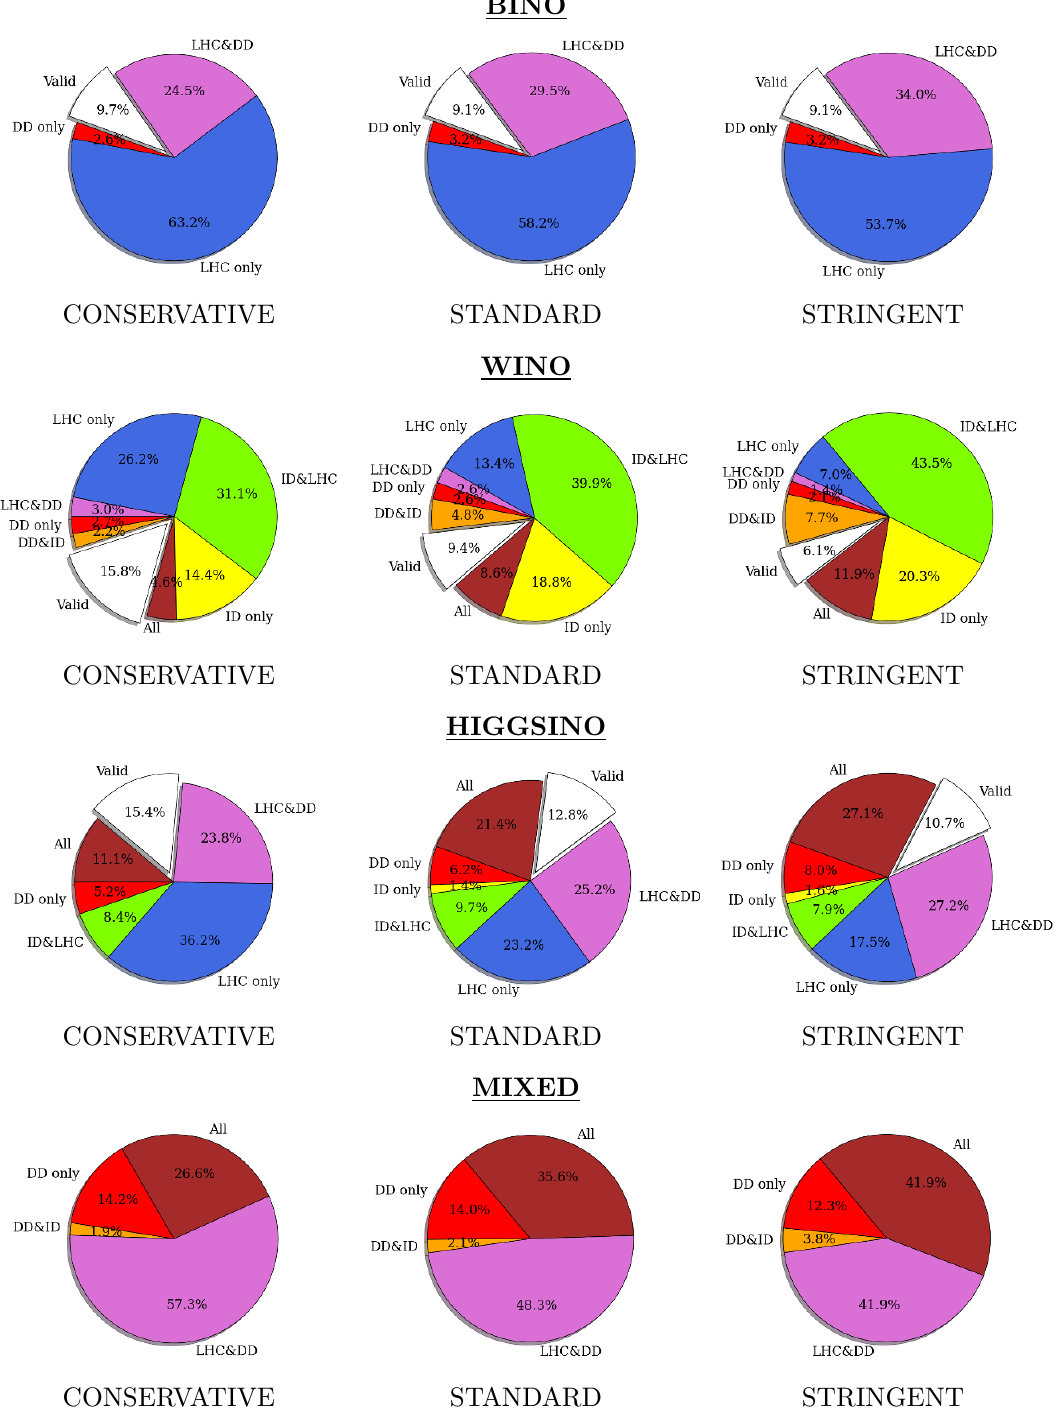
Figure 22 . Fraction of pMSSM points satisfying the light Higgs mass, relic density, LEP and (cid:13)avour constraints, and excluded by direct and indirect detections and LHC constraints, for the di(cid:11)erent neutralino 1 types.